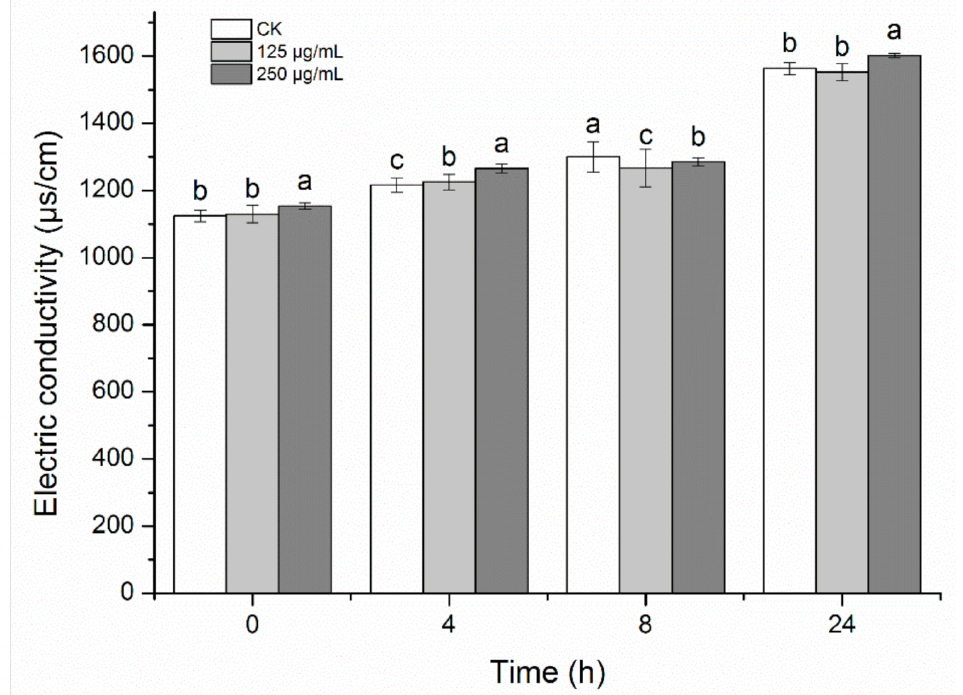
Figure 8. Effect of HBA on membrane permeability of A. avenae subsp. citrulli . Note: Columns followed by different letters indicate significantly different scores in the same phase according to Duncan’s multiple range tests at the p < 0.05 significance